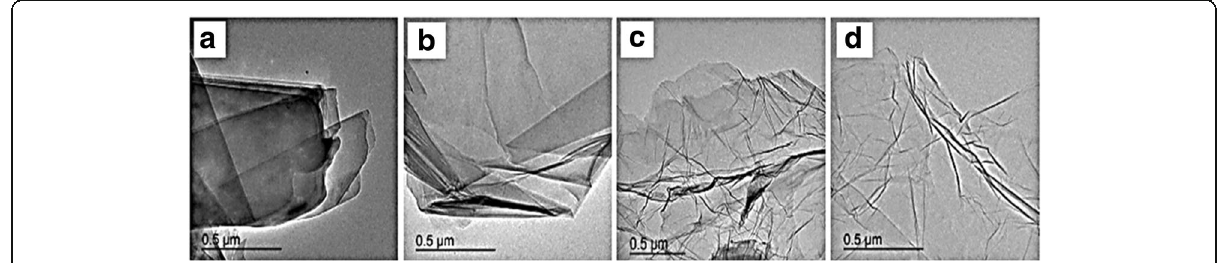
Fig. 5 TEM images of graphite ( a ), GO ( b ), GN-900 ( c ), and GN-900-C [143]